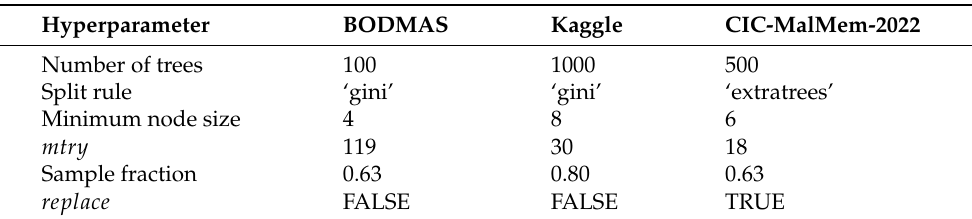
Table 2. The final learning parameters of random forest used for each dataset after performing a random search